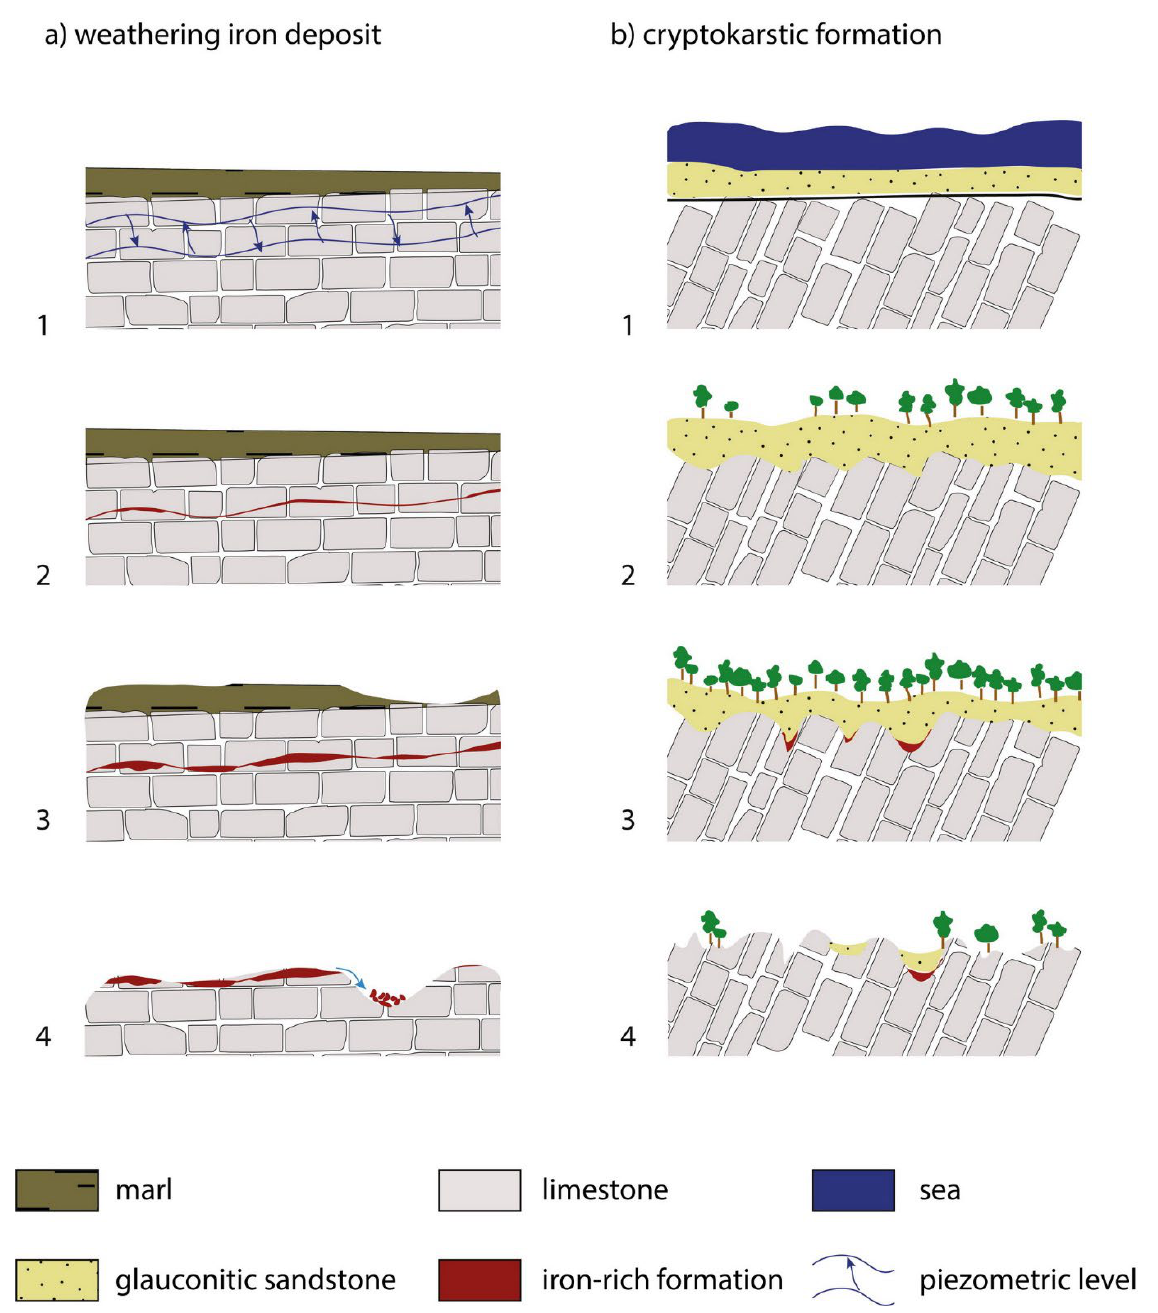
Figure 6. Formation of a) Iron weathering deposits in karst: 1-2) Direct weathering of limestone to iron-rich clay minerals, 3) Leaching and precipitation of iron at strata surfaces or in karsts, 4) Erosion of upper strata and iron precipitation and accumulation in karst depressions; b) Cryptokarstic iron deposits: 1) Glauconite-rich sand deposit over older limestone strata, 2) Growth of tropical vegetation - leaching of iron by percolating acidic waters, limestone weathering and cryptokarst formation, 3) Humid, tropical climates accelerate karstification and iron precipitation at the contact between sandstone and limestone, 4) Quaternary erosion and weathering of iron formations. Diagram: A. Chassin de Kergommeaux (after Quinif